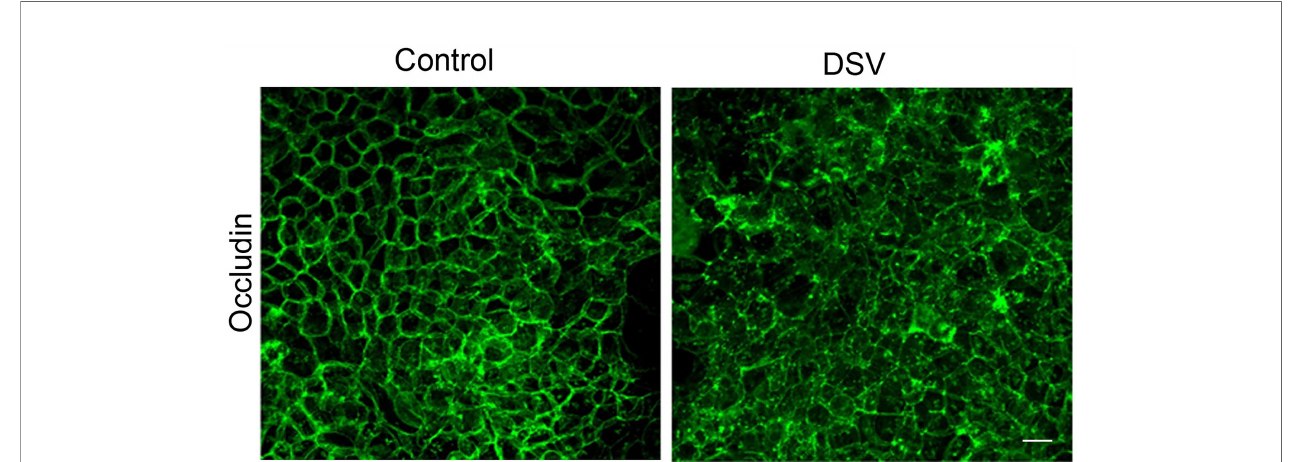
FIGURE 2 | DSV induced changes in the localization of Occludin. Polarized Caco-2 cells were infected with DSV (MOI 20) for 24 hours. Cells were then fi xed with 4% paraformaldehyde. After blocking in solution containing 5% FBS, 0.3% TritonX-100 in PBS, cells were incubated with anti-occludin antibody (in 1% BSA with 0.1% TritonX-100 in PBS) overnight at 4 ˚ C. Cells were washed with PBS and incubated further with secondary anti-rabbit Alexa Flour-488 antibody for 2 hours at room temperature. Cells were washed and mounted using Prolong Gold (Thermo Fisher). Cells were visualized with Olympus Fluoview FV1200 confocal microscope. Z-stacks were performed for each image and the fi nal images were collected after compressing the z-stacks